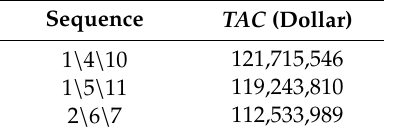
Table 11. Remaining sequences’ costs of the petroleum refinery case after